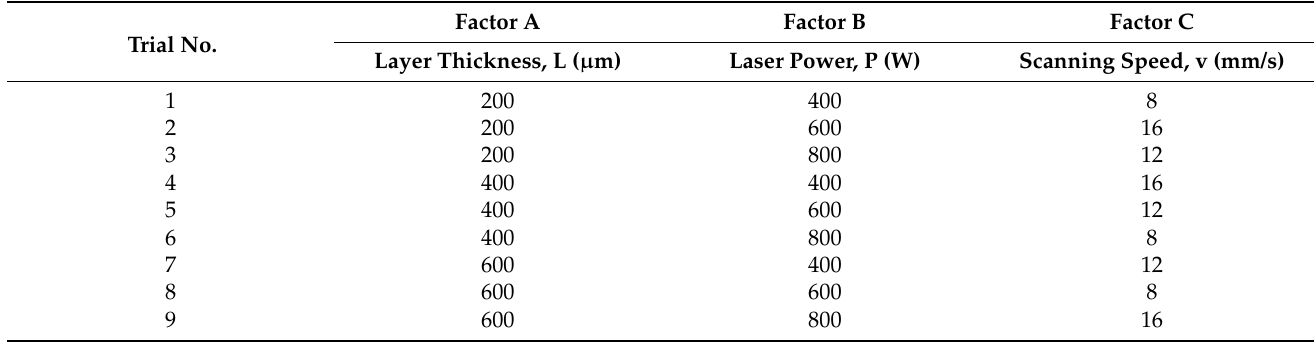
Table 4. Design of the orthogonal array